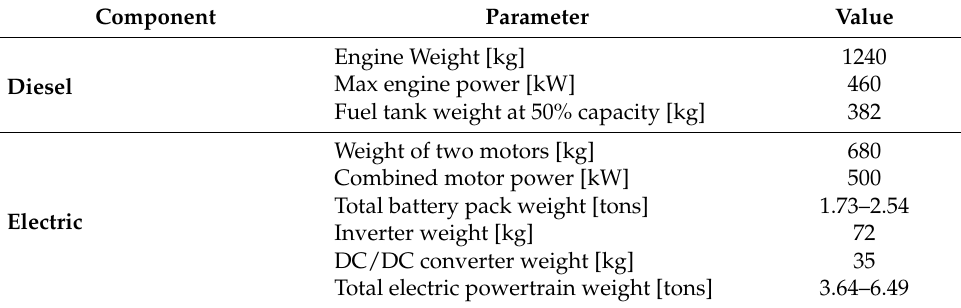
Table 3. Weight of Diesel and Electric powertrain